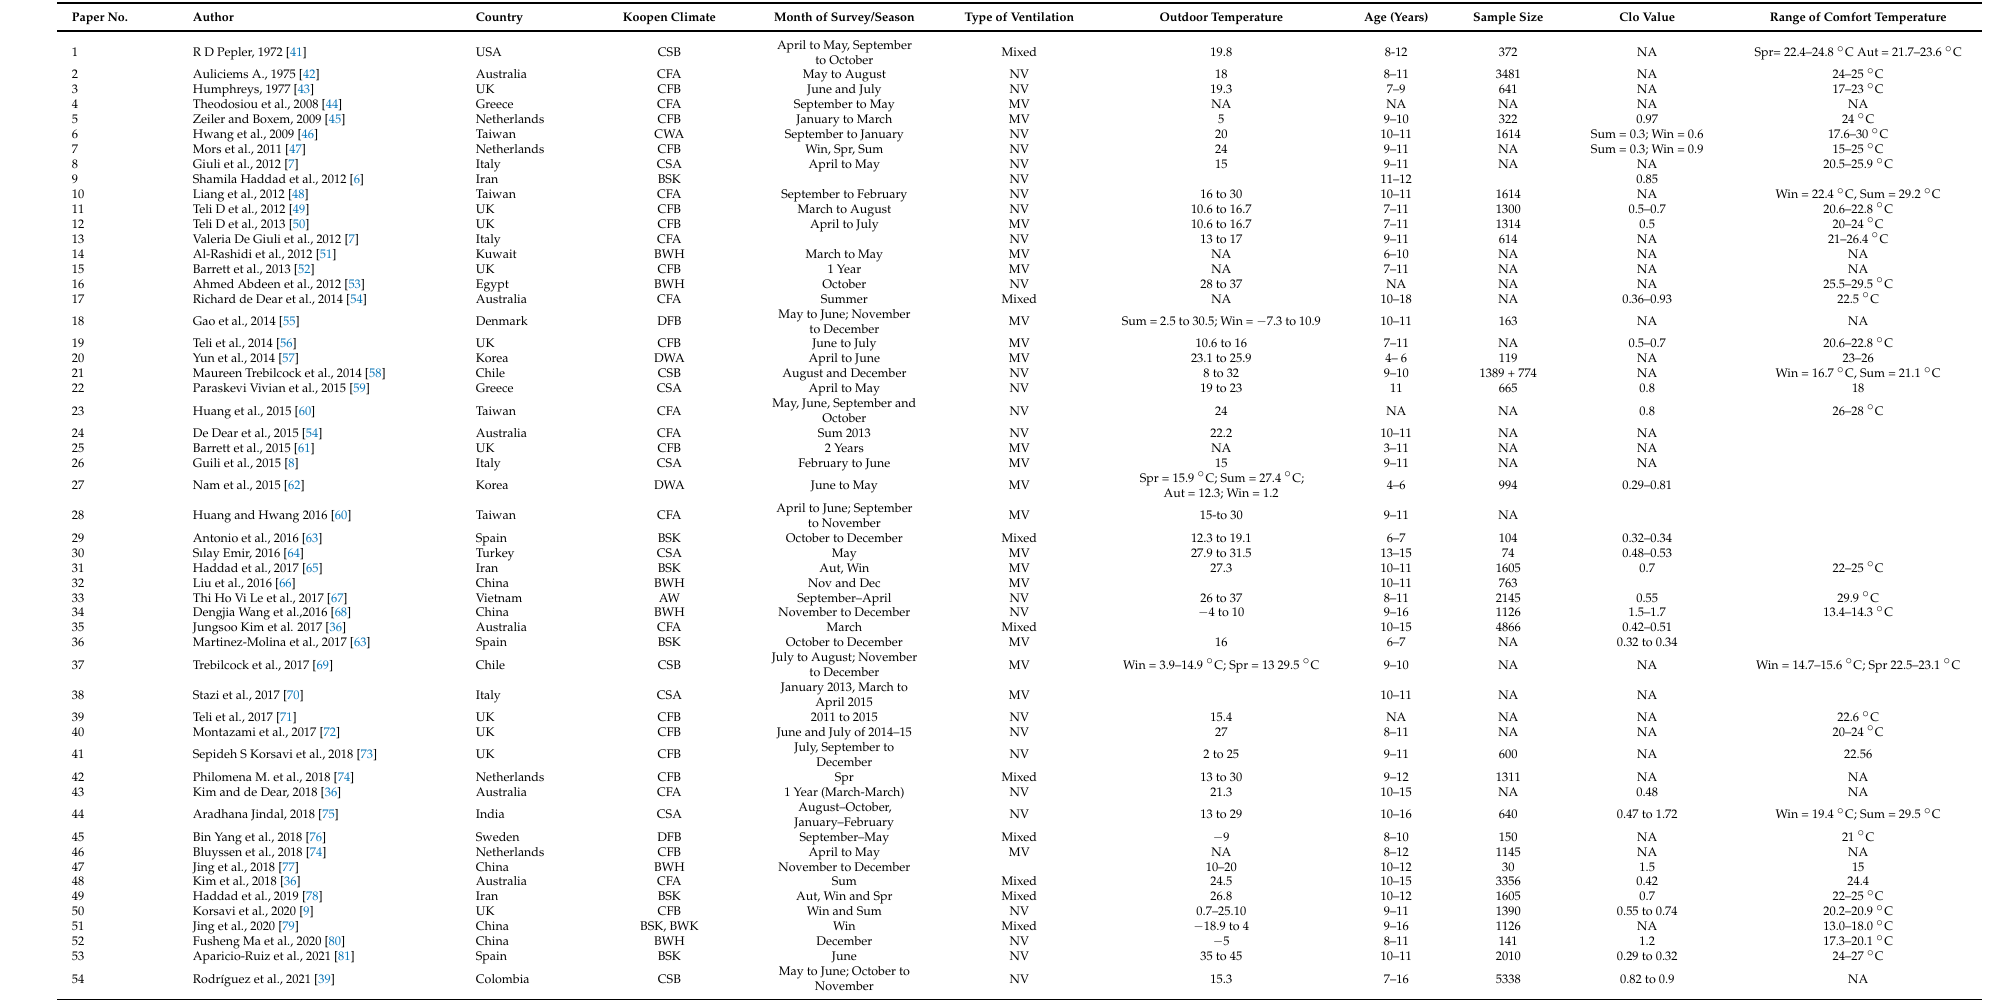
Table 2. Statistics on notable thermal comfort studies on primary school students in the past 60